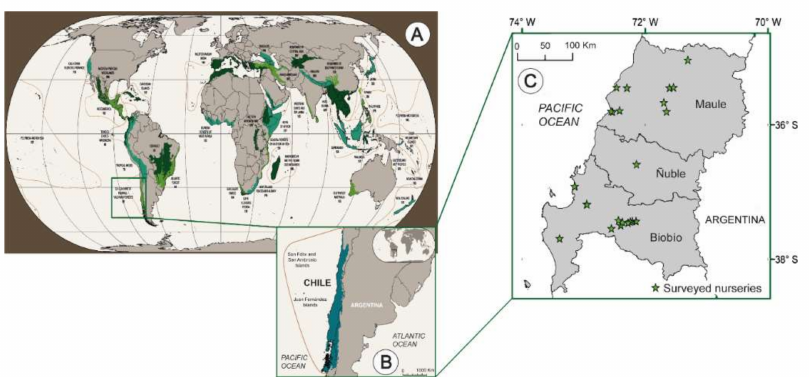
Figure 1. Global hotspots of biodiversity (( A ); modified from [7]) including the Valdivian Forests of Chile ( B ) where the Maule, Ñuble, and Biob í o regions occur ( C ). These three regions account for 78% of the national plant production. Green stars indicate locations of surveyed nurseries ( C